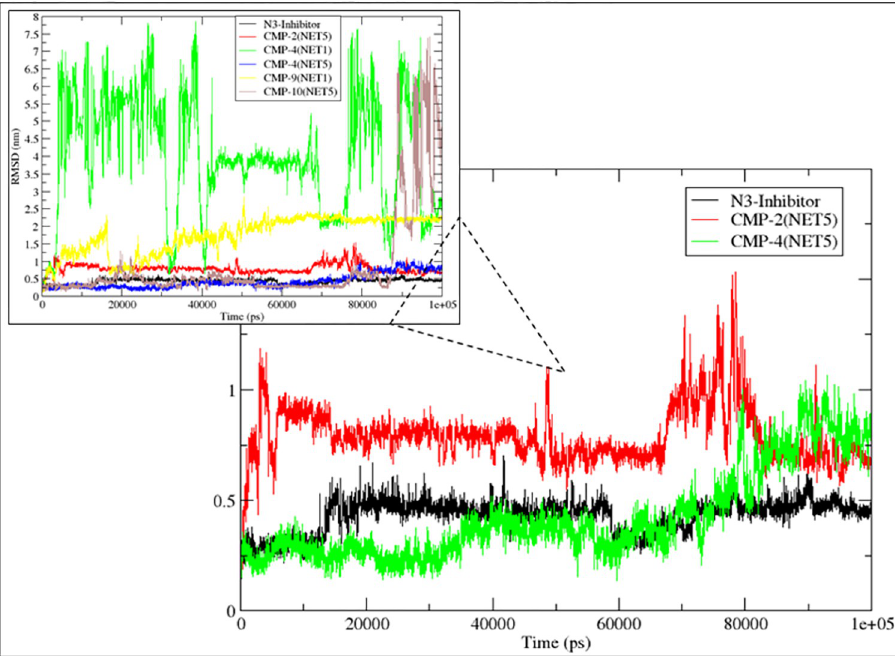
Fig 5. The RMSD of the ligands calculated over 100 ns MD simulation trajectories for the top five hits (CMP4 (NET1) , CMP9 (NET1) , CMP10 (NET5) , CMP2 (NET5) , CMP4 (NET5) ) and the reference ligand N3. The bigger plot zooms the RMSD of native inhibitor N3, CMP2 (NET5) and CMP4 (NET5) .